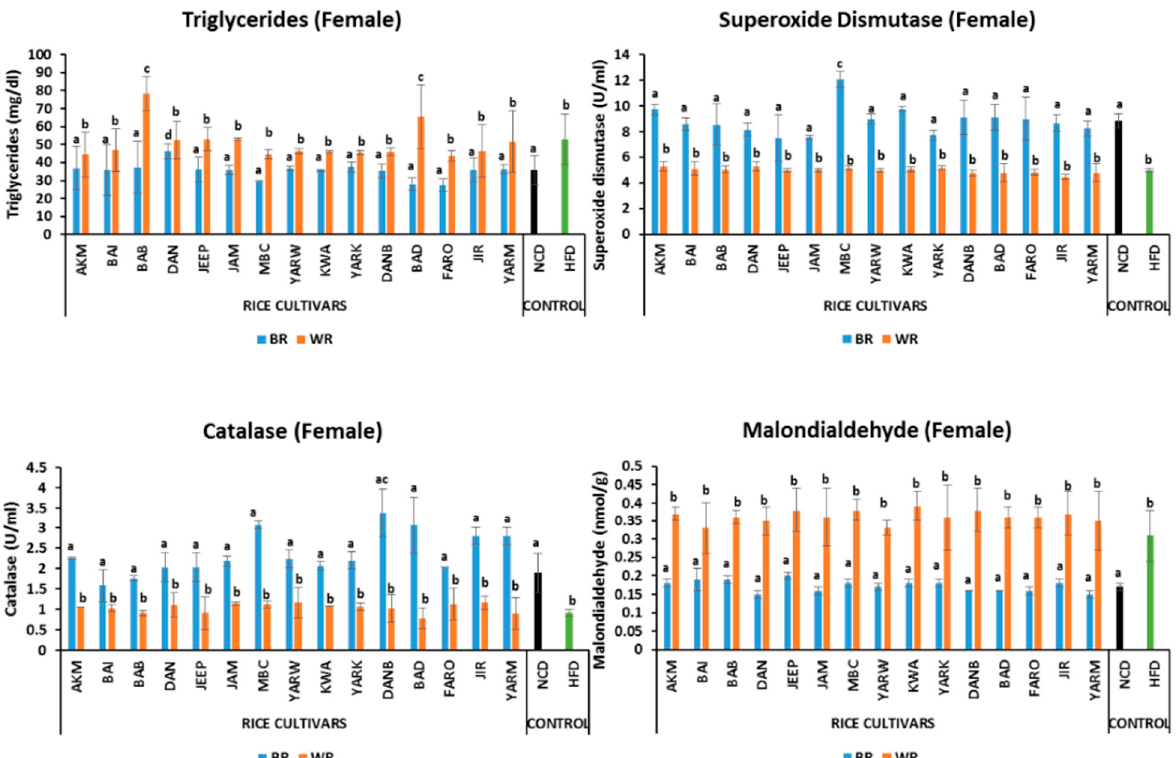
Figure 4. Effects of rice cultivars on triglyceride level and oxidative stress markers in female flies after 7 days of intervention. Bars represent mean ± SD. Bars denoted by the same letters are not significantly different ( p > 0.05). (n = 30). Black and green bars represent the groups fed normal diet and high-fat diet respectively. NCD = normal diet, HFD = high-fat diet, Akai maza hajj = AKM, Baingila = BAI, Baburashi = BAB, Jamila = JAM, Maibakincarki = MBC, Yarwasagi = YARW, Kwandala = KWA, Yarkatabore = YARK, Danboto = DANB, Bakindanboto = BAD, Faro 44 =